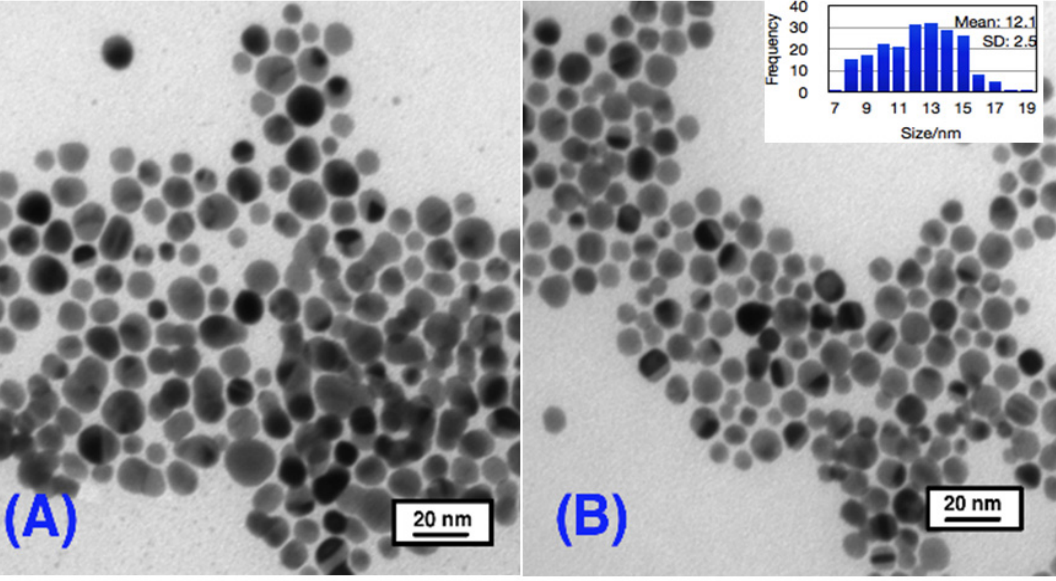
Figure 11. UV-Visible spectrum of Au-hexadecylamine colloid by inverse micelle method before and after digestive ripening 2 h in